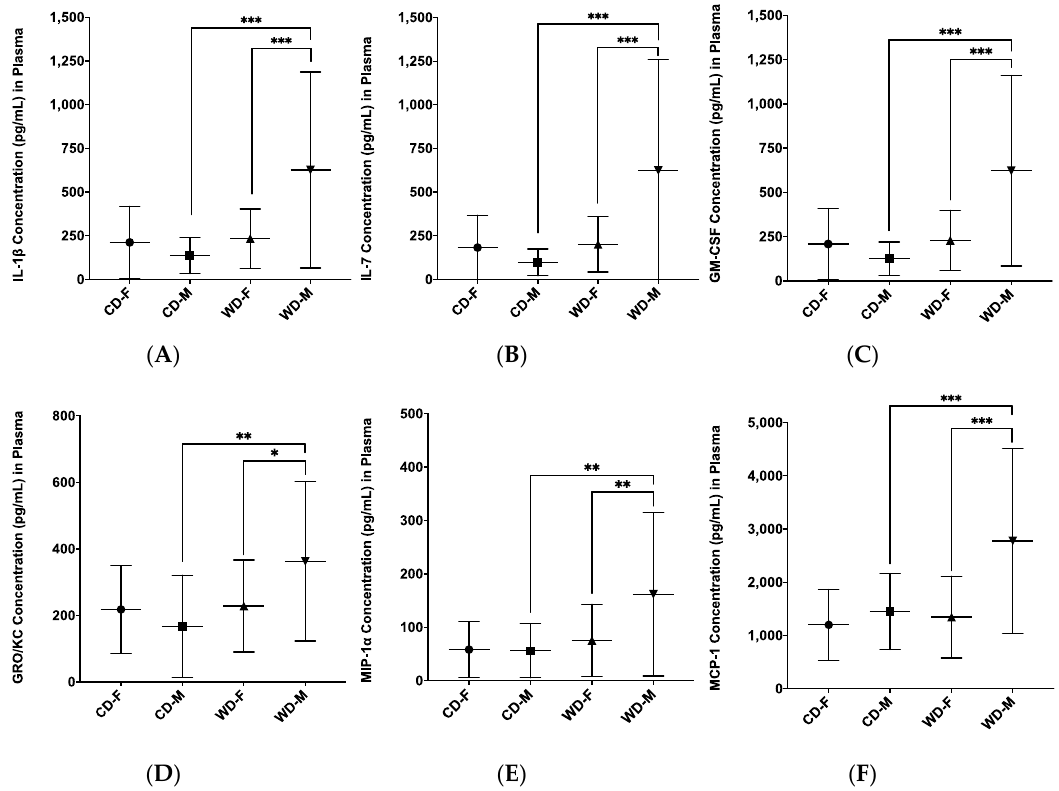
Figure 10. Diet by sex interactions in plasma inflammatory analytes from factorial ANOVA analyses for ( A ) IL-1 β , ( B ) IL-7, ( C ) GM-CSF, ( D ) GRO/KC, ( E ) MIP-1 α , and ( F ) MCP-1. Data expressed as M ( SD). * p < 0.05, ** p < 0.01, *** p < 0.001. WD: Western diet; CD: control diet; M: male; F: female.